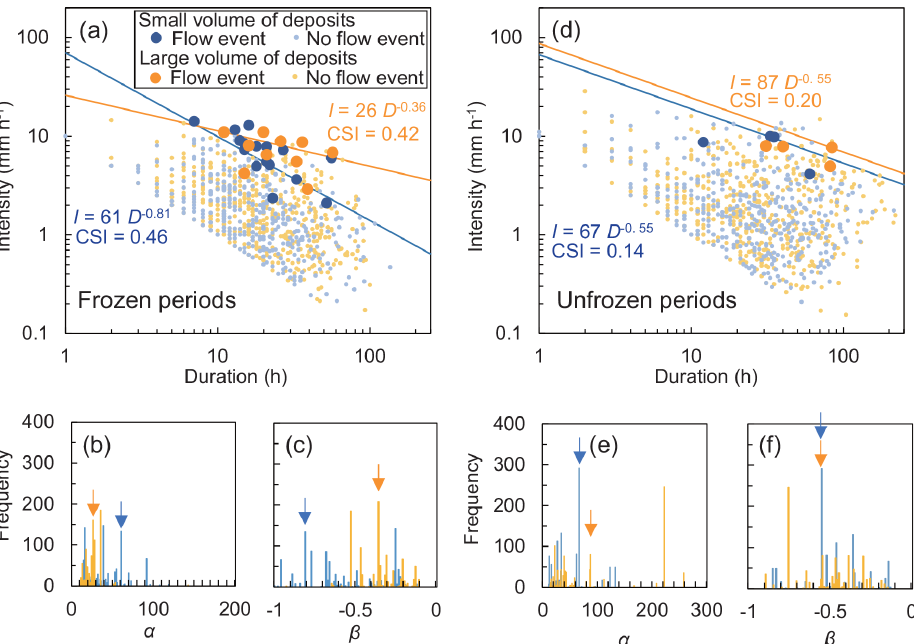
Figure 11. Comparison of the duration and intensity of rainfall events with or without debris flows and slush avalanches, analyzed according to the volume of channel deposits. The boundary between the two volume classes was set to 350000m 3 . (a) Comparison during frozen periods. The frequencies of (b) constant α and (c) slope of the power-law curve β , which produced the highest critical successful index (CSI), obtained by 1000 bootstrap resamplings during frozen periods. (d) Comparison during unfrozen periods. (a) Comparison during frozen periods. Frequencies of the (e) constant α and (f) slope of the power-law curve β obtained by bootstrap resampling during unfrozen